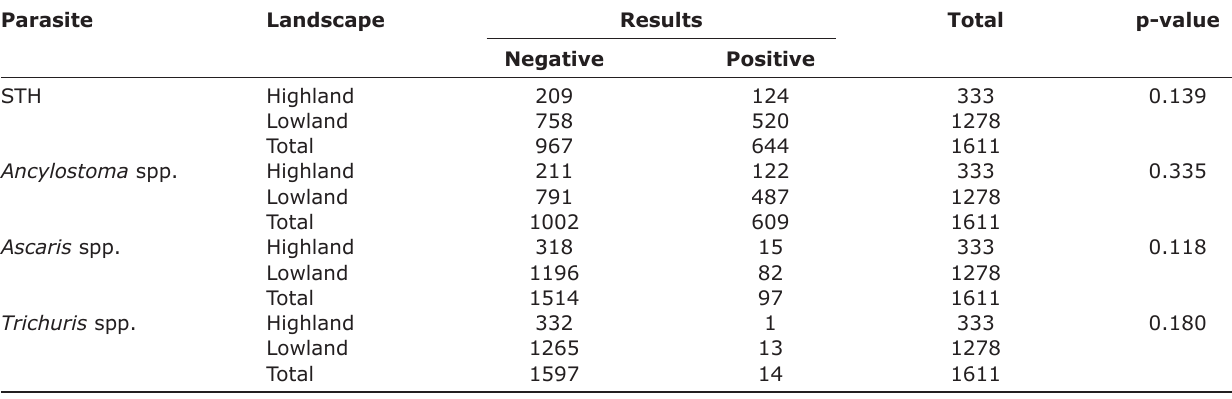
Table-7: The prevalence of soil-transmitted helminths infection according to the landscape. Parasite